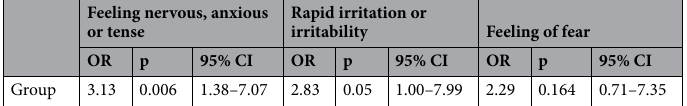
Table 7. Univariate analysis variables in Group Ia and Ib.